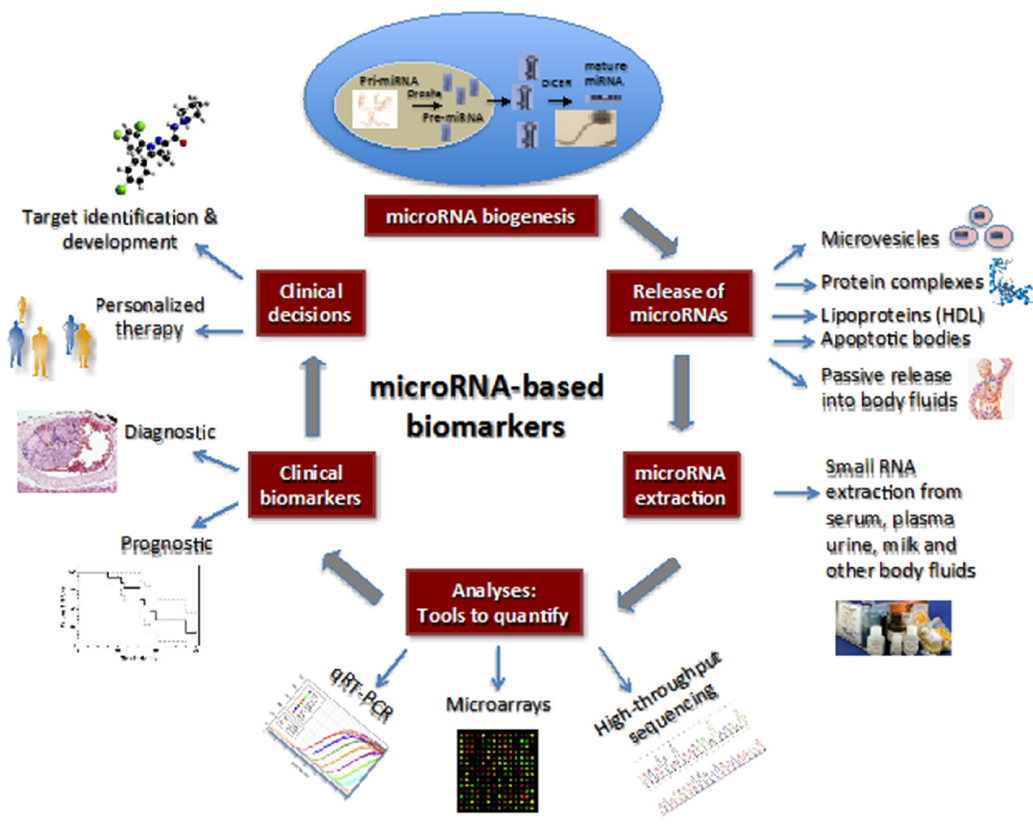
Figure 2. miRNA-based biomarkers. The schematic diagram shows the biogenesis of miRNAs and their secretion into body fluids through various mechanisms, which include mirovesicles, protein complexes, lipoproteins, apoptotic bodies, and passive release. The secreted miRNAs can be extracted with small RNA extraction kits and analyzed for the presence of mature miRNAs with different quantitative approaches. The profile of miRNA populations is used to determine the diagnosis and/or prognosis of the patient’s clinical disorder. On the basis of diagnostic and prognostic utilities, a clinical decision can be made for the targeted and personalized treatment of the disease. Reprinted with permission from “Circulating MicroRNAs as Biomarkers: A New Frontier in Diagnostics” ( Liver Transplant. 2012 ).